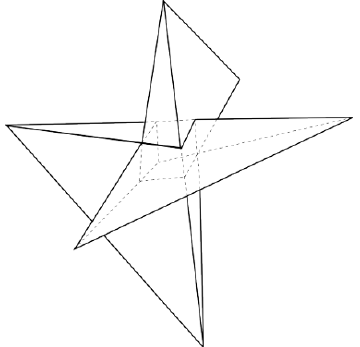
Figure 8 . The three-dimensional analogue of (cid:12)gure 4, showing the three possible ways of forming a triangulation analogous to that shown in (cid:12)gure